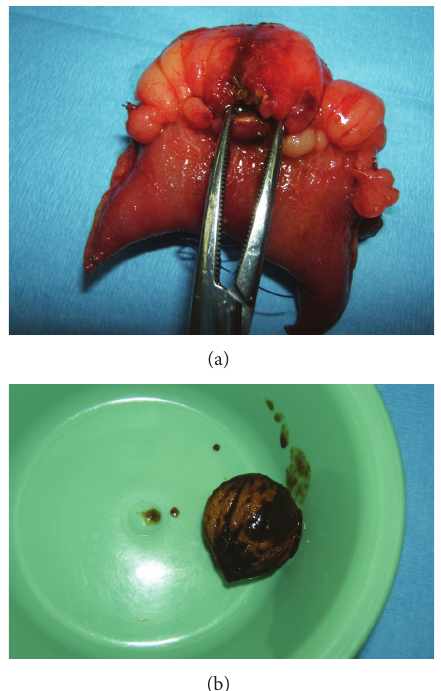
Figure 2: Small bowel perforation and offending